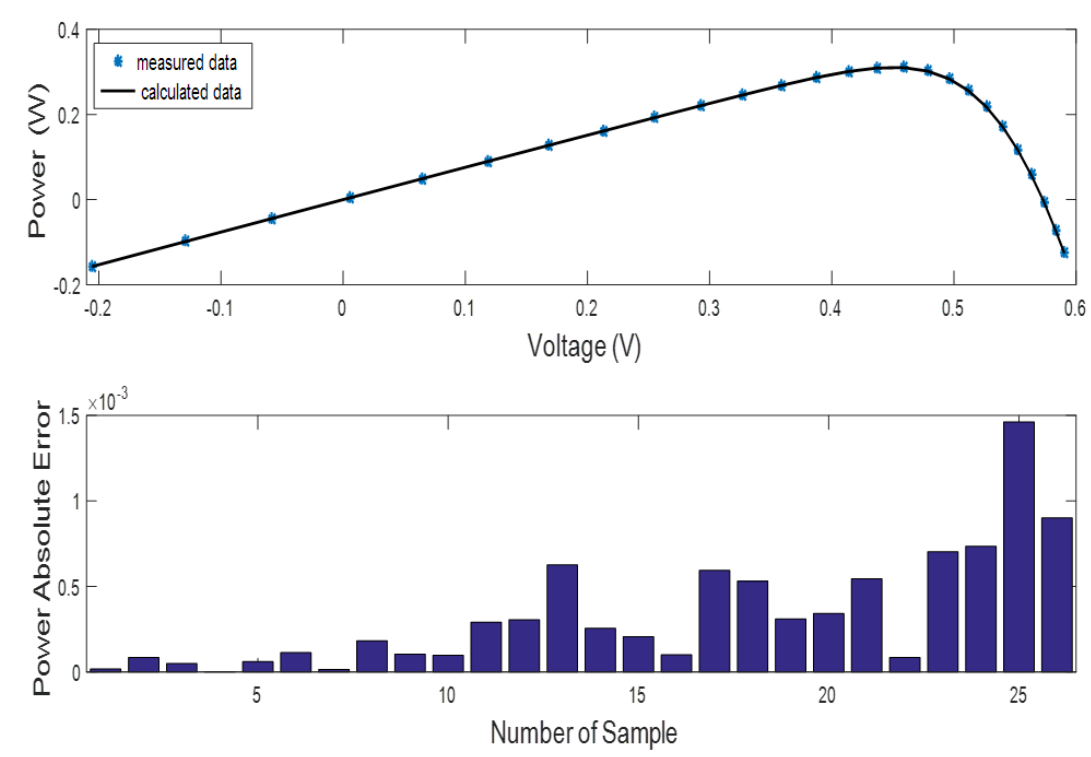
Figure 8. The SDMSC’s P–V curve based on the best solution from the INFO algorithm.